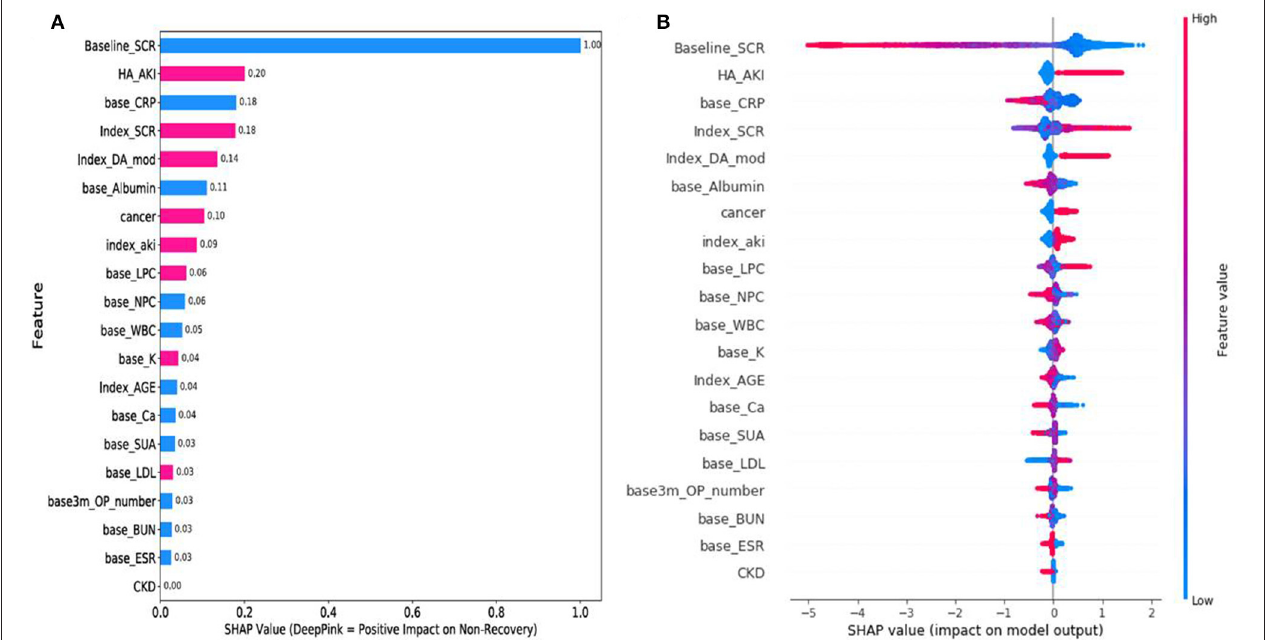
FIGURE 2 | SHapley Additive exPlanations (SHAP) results. (A) SHAP feature importance. Eight features with deep pink color had a positive effect on AKI non-recovery prediction, 11 features with blue color were negatively correlated with AKI non-recovery prediction (1 with neutral), and a higher mean SHAP value has a higher effect on outcome prediction. (B) SHAP summary plot. The x -axis denotes the SHAP value for each feature, whereas the color represents the feature value ( y -axis) from high to low (deep pink to blue). SHAP, SHapley Additive exPlanations and AKI, acute kidney